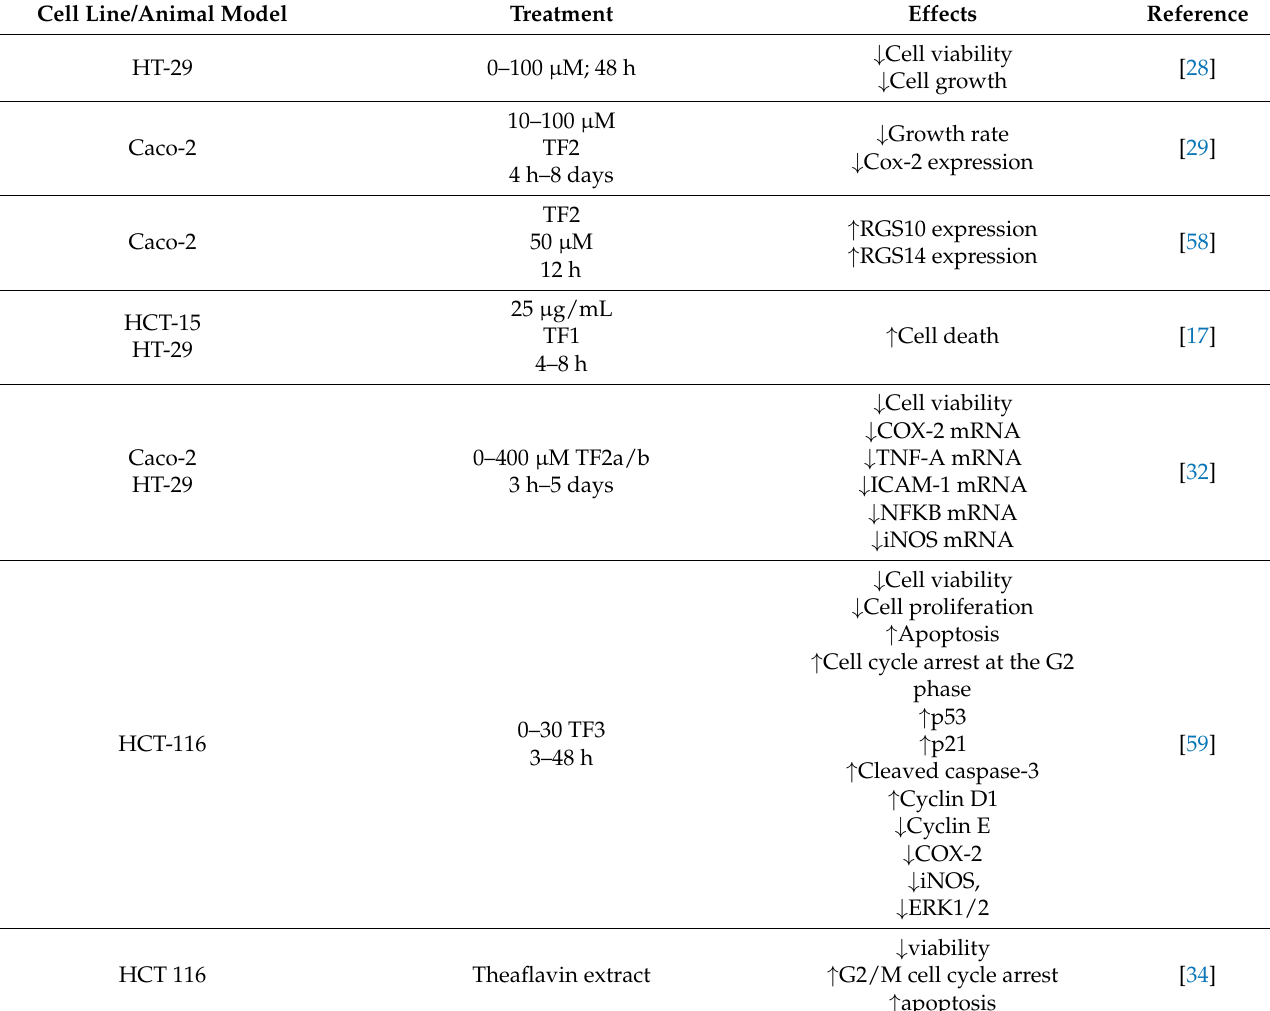
Table 8. Effects of theaflavins in colon